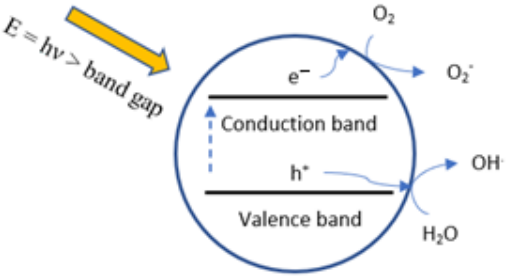
Figure 1. Schematic of the photocatalytic process to form hydroxyl radicals. The absorption of light, at sufficient energy to overcome the band-gap of the photocatalyst (e.g., TiO 2 ), will generate an electron-hole pair (Equation (1)).